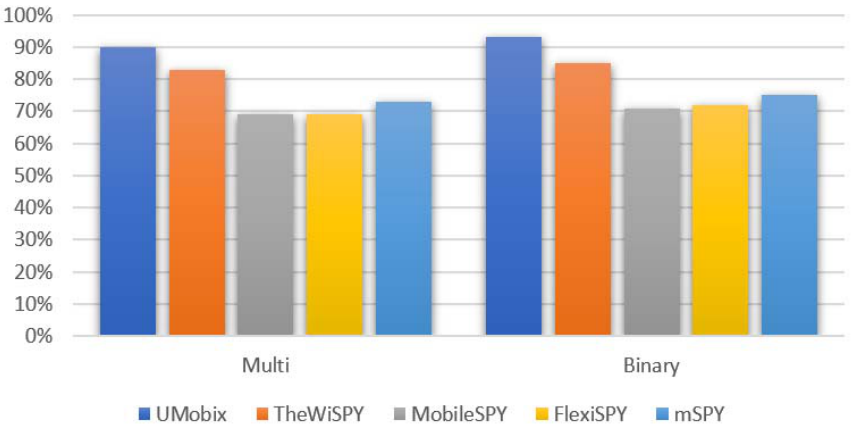
Figure 11. Classification accuracy results.